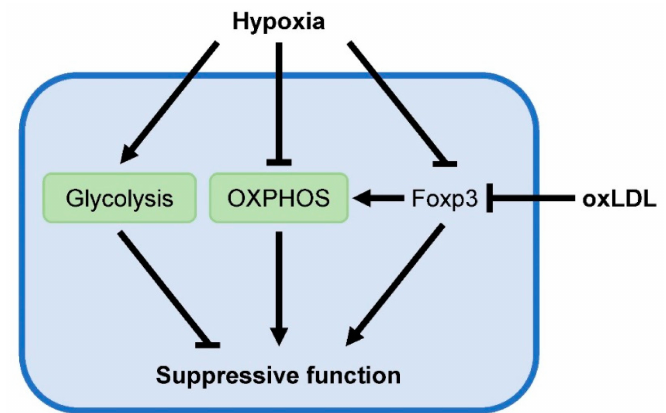
Figure 4. Putative influences of the atherosclerotic plaque microenvironment that negatively a ff ect suppressive Treg function. Plaque hypoxia may induce proteasomal degradation of Foxp3 and reduce OXPHOS in Tregs, required for their suppressive functions. Additionally, oxidized LDL particles present in the plaque can downregulate Foxp3 expression and attenuate the suppressive Treg